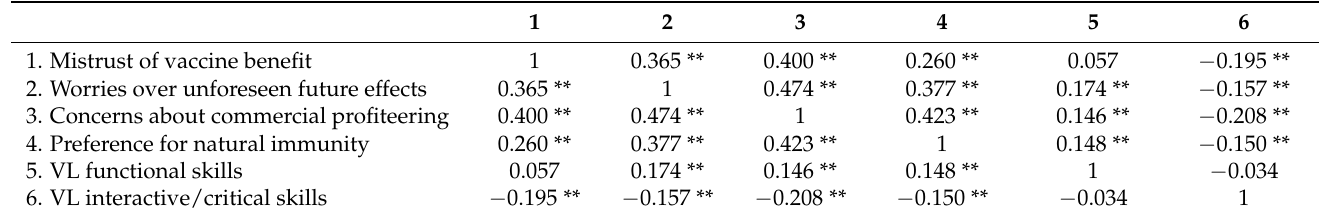
Table 7. Correlations in skills, perceptions, attitudes and beliefs toward